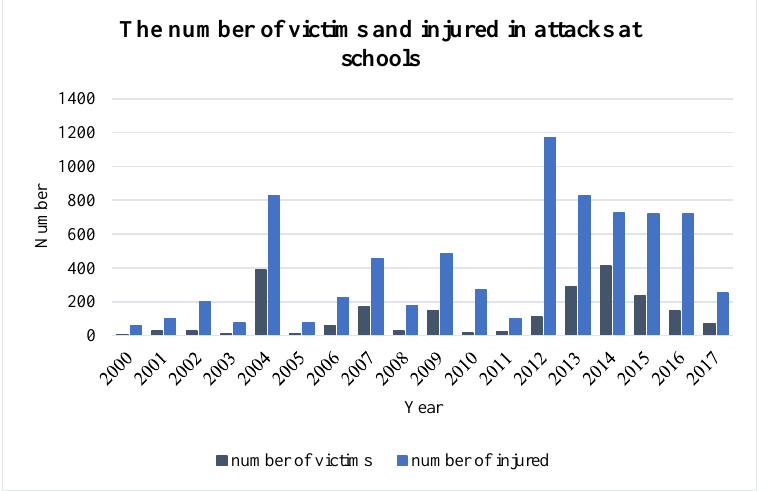
Figure 3. The number of victims and people injured in attacks at schools and school facilities between 2000 and 2017 in the world [20].